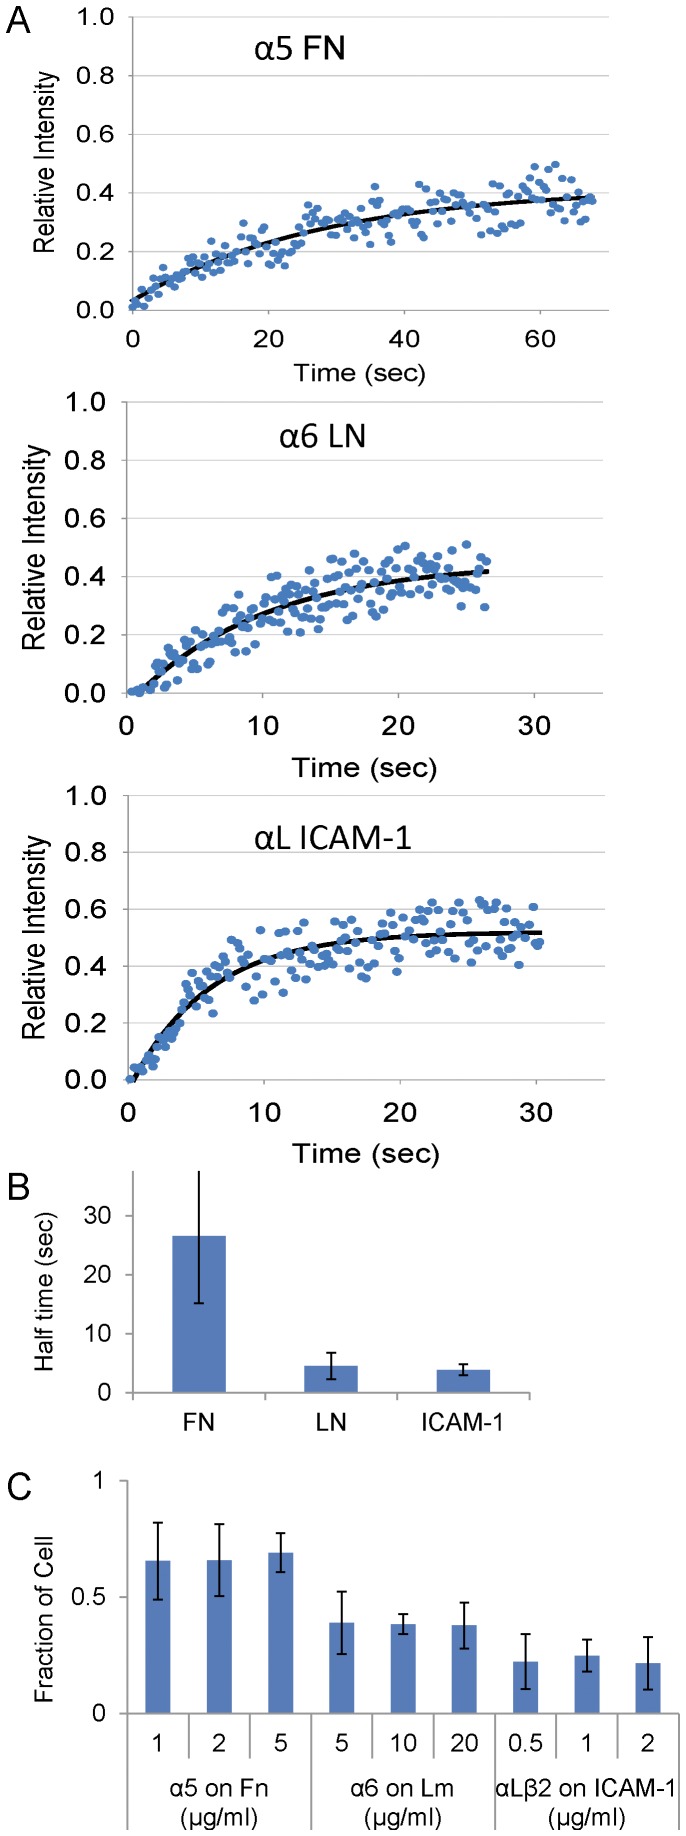
Fluorescence Recovery After Photobleaching (FRAP) and adhesion assays for CHO.B2 cells expressing α5, α6 or αL+β2 integrins and migrating on FN, LN and ICAM-1, respectively.(A) Typical FRAP curve for each condition. Data points are in blue, and a single exponential fit is in black. Notice the time scale differences. The R2 for a single and double exponential fit were both 0.8. From the single exponential fits, the fractional recoveries for the three typical curves are 0.39, 0.49, 0.56, respectively; estimated half-times (T1/2, sec) are 19, 6.3, 4.1, respectively. (B) From the single exponential fits, recovery half-times (T1/2) were plotted as mean ± SD. The T1/2 for α5-GFP is significantly larger than for either α6-GFP or αLβ2-GFP (n = 3 cells for each condition, P<0.05). (C) Adhesion strength assay. Cells expressing α5, α6 or αL+β2 integrins were plated onto substrates coated with FN, LN, or ICAM-1, then either simply inverted (positive control), or inverted and centrifuged at low speed (200 RPM). The number of remaining cells was counted. The relative adhesion strength was estimated by the fraction of cells remained after centrifugation divided by the positive control. More cells remained on FN than on LN or ICAM-1: P<0.04.